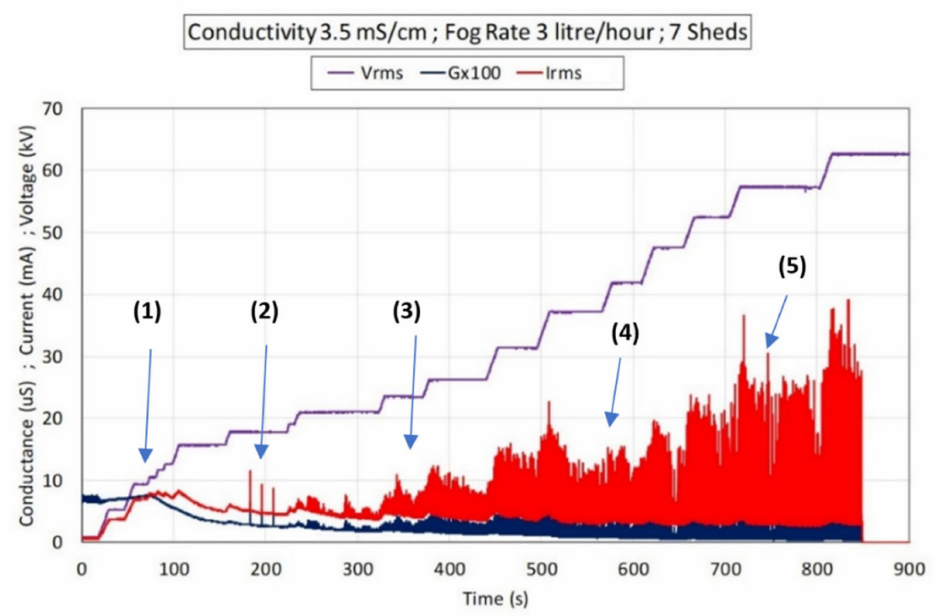
Figure 9. Surface conductance, leakage current, and applied free ramp voltage for medium pollution. (1), (2) (3), (4) and (5) are areas where LC activity and magnitude